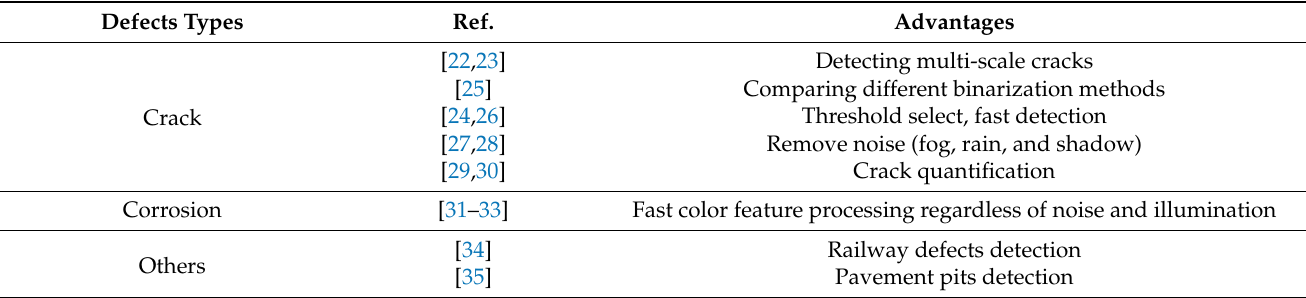
Table 1. Summary of image processing